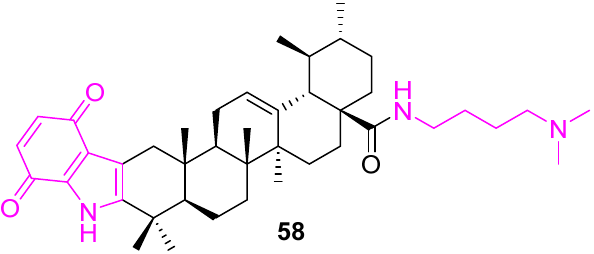
Figure 40. Structure of 58 .